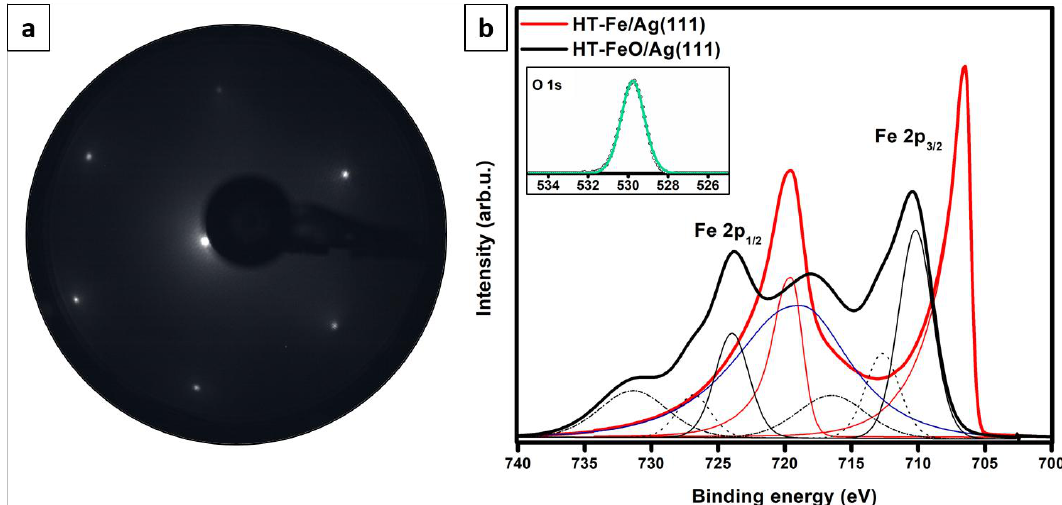
Figure 4. LEED pattern (60 eV) of 0.5 ML FeO film grown by Fe deposition onto Ag(111) substrate kept at 550 K and post-oxidation ( a ). ( b ) shows XPS Fe 2p spectra obtained for the 1.0 ML HT-Fe/Ag(111) (red line) and 1.0 ML HT-FeO/Ag(111) (black) samples. The Ag 3s signal is marked in blue. Inset in (b) presents the O 1s spectrum (green line) recorded for the oxidized sample.